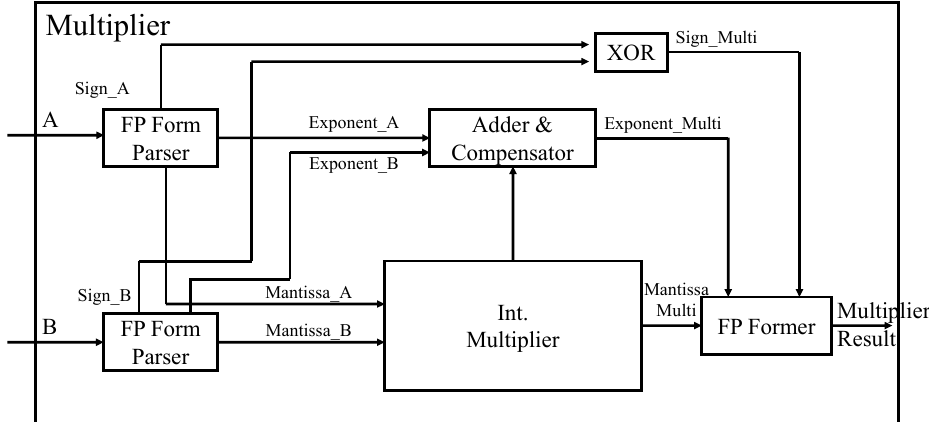
Figure 8. The architecture of proposed floating-point multiplier.